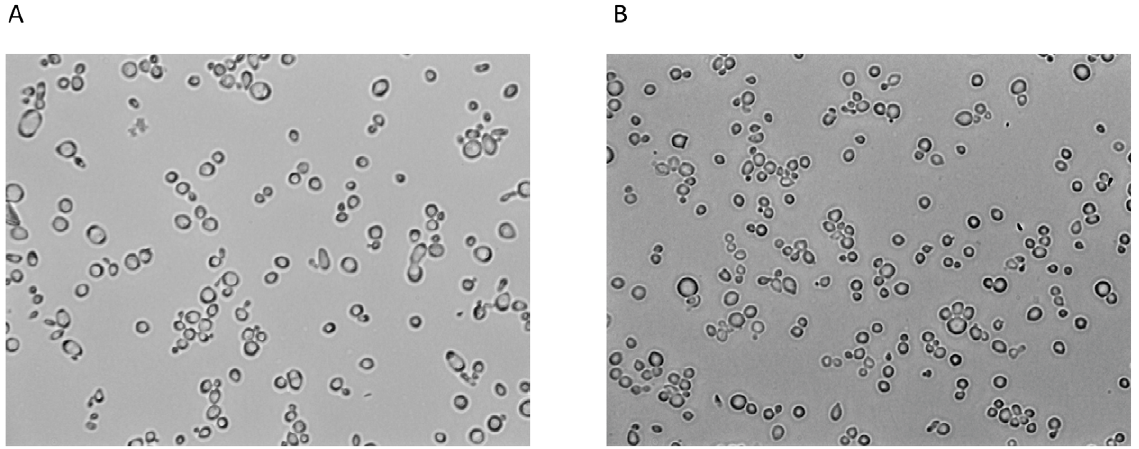
Figure 1. Morphologies of fresh and lyophilized yeast. Ten microliters of fresh induced (Panel A) or lyophilized and rehydrated (Panel B) yeast- scFv clone 350-E2 was analyzed by light microscopy at 40 6 magnification.